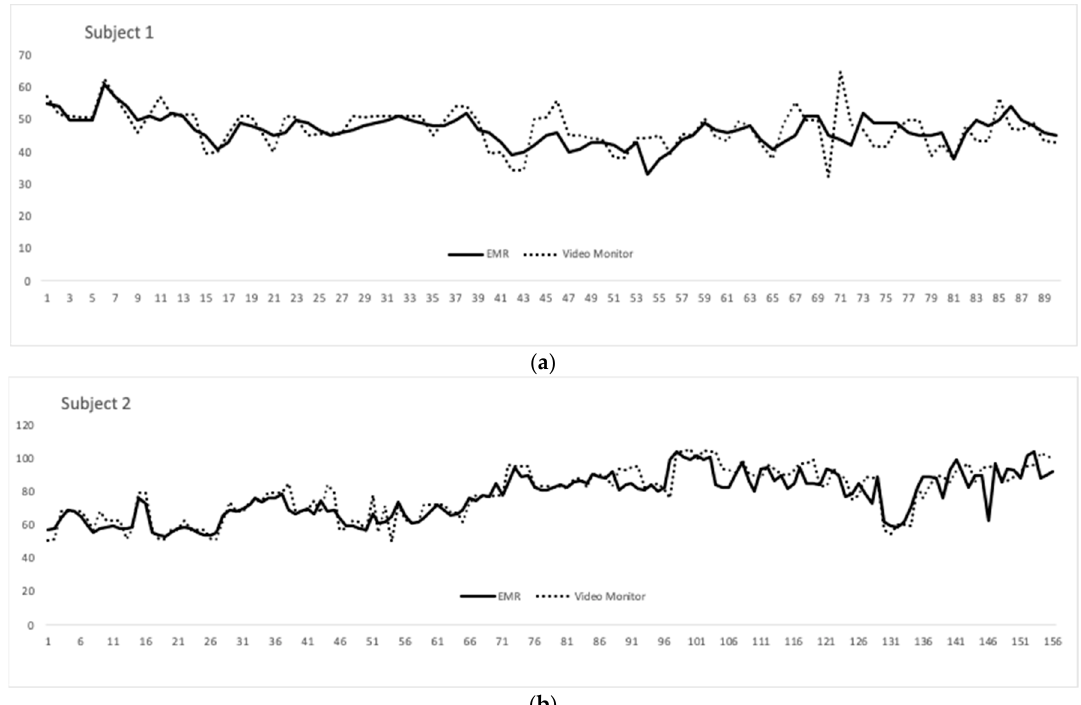
Figure 3. ( a ) Respiratory rate (RR) (y-axis) from the video monitoring system compared to that of the extracted Electronic medical record (EMR) data over a 8.4 minute recording made up of 90 time points (x-axis); ( b ) RR (y-axis) from the video monitoring system compared to that of the extracted EMR data over a 13.4 minute recording made up of 155 time points (x-axis)